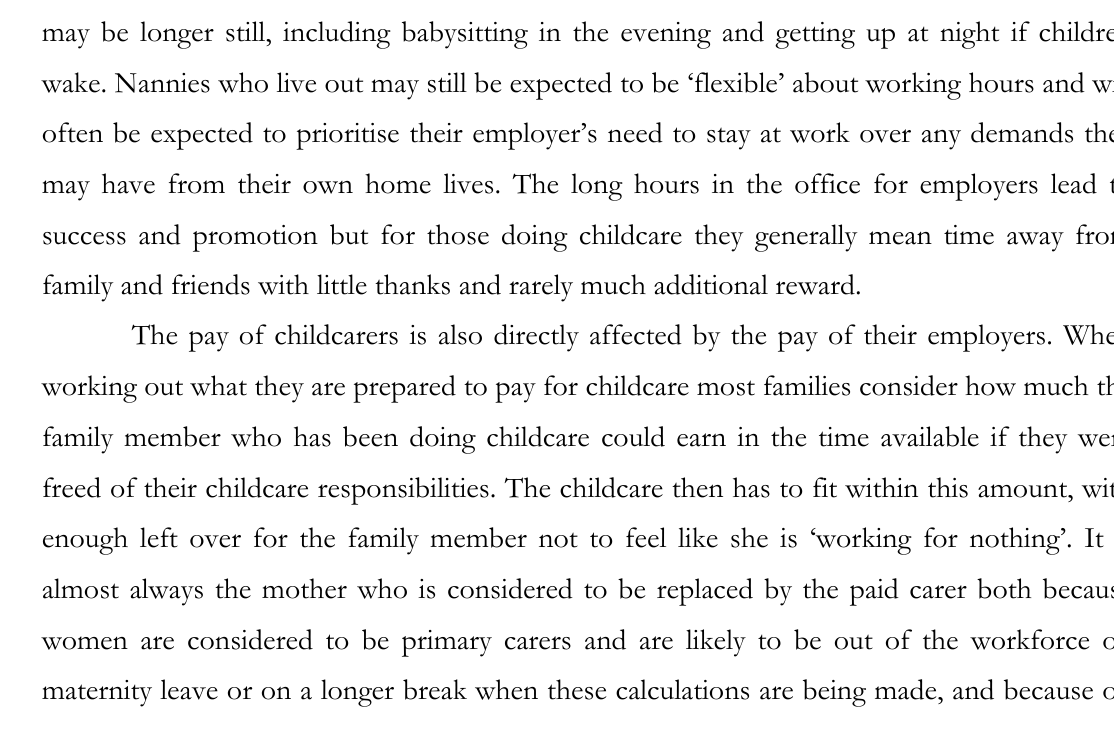
Rosie Cox: Competitive Mothering and Delegated Care: Class Relationships in Nanny and Au Pair